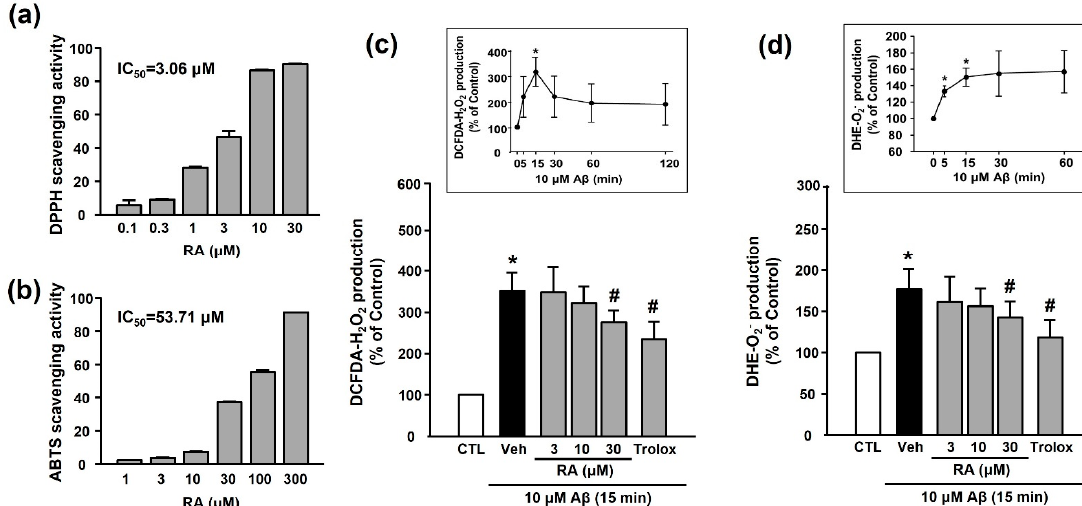
Figure 3. Antioxidant activity of RA in vitro and in platelets. ( a ) DPPH radical-scavenging activity of RA in vitro. Data are presented as the mean ± SEM of three individual experiments. ( b ) ABTS radical-scavenging activity of RA in vitro. Data are presented as the mean ± SEM of three individual experiments. ( c ) A β 1–40 -induced H 2 O 2 production in platelets quantified by measuring DCF-DA fluorescence intensity. (c, insert) Time course of A β 1–40 -stimulated H 2 O 2 generation. Platelets were treated with 10 µ M A β 1–40 for indicated time periods (0–120 min) in the presence of DCF-DA. Data are presented as the mean ± SEM of six experiments. ( d ) A β 1–40 -induced O 2 − production in platelets quantified by measuring DHE fluorescence intensity. ( d , insert) Time course of A β 1–40 -stimulated O 2 − generation. Data are presented as the mean ± SEM of six experiments. * p < 0.05 compared with CTL, # p < 0.05 compared with Veh. DPPH, 2,2-diphenyl-1-picrylhydrazyl; DHE, dihydroethidium; ABTS, 2,2’-azinobis(3-ethylbenzothiazoline-6-sulfonic acid; DCF-DA, 2’-7’-dichlorodihydrofluorescein diacetate; ROS, reactive oxygen